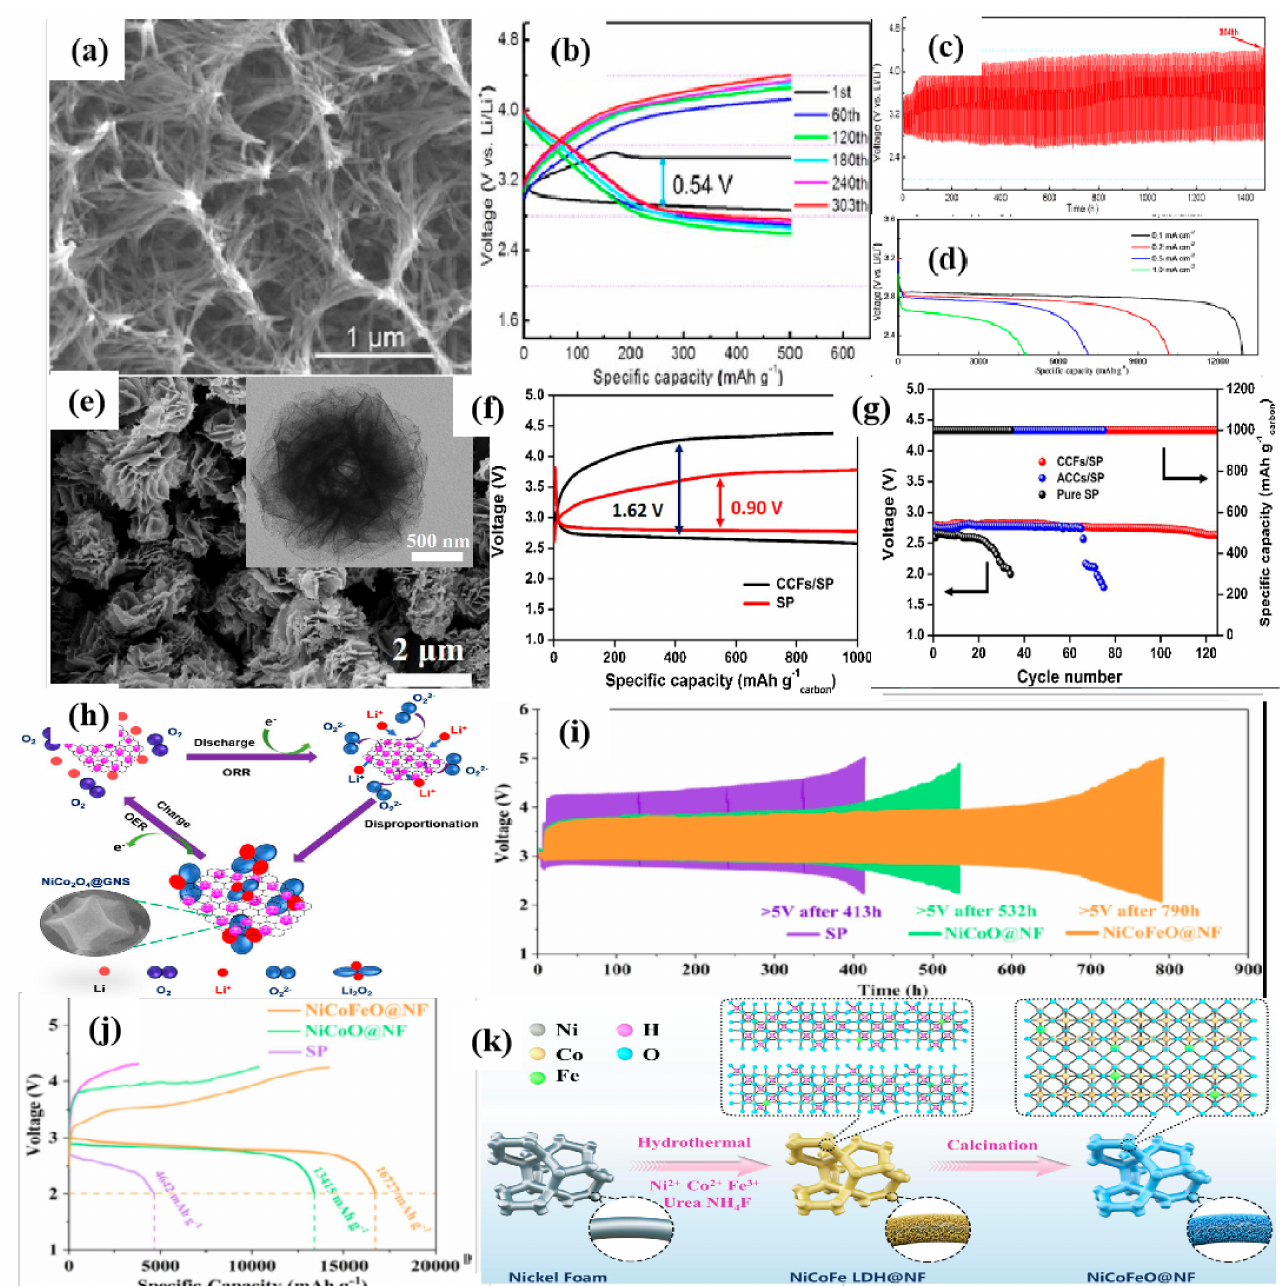
Figure 11. ( a ) Surface morphology and selected area electron diffraction (SAED) spectra of MnCo 2 O 4 samples. ( b ) Constant current discharge/charging curve of different cycles and ( c )